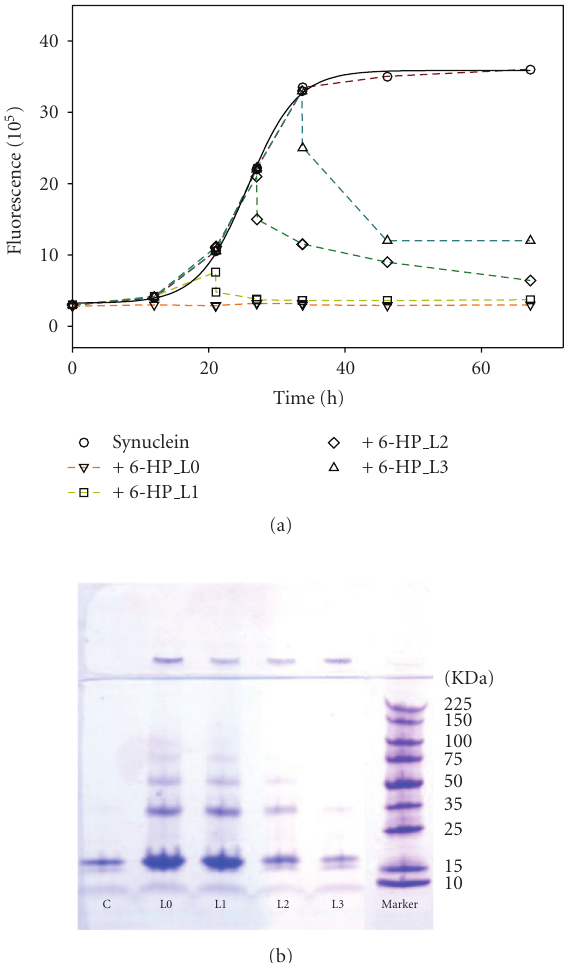
Figure 10: The e ff ect of baicalein on α -synuclein fibrillation at di ff erent stages by monitoring the kinetics of α -synuclein fibrillation (a) and the SDS-PAGE of the supernatants at the end of reaction (b) for the sample with baicalein added at various times, that is, 0 hour (sample L0), 12 hours (end of nucleation, sample L1), 21 hours (middle of elongation, sample L2), and 33 hours (end of elongation, sample